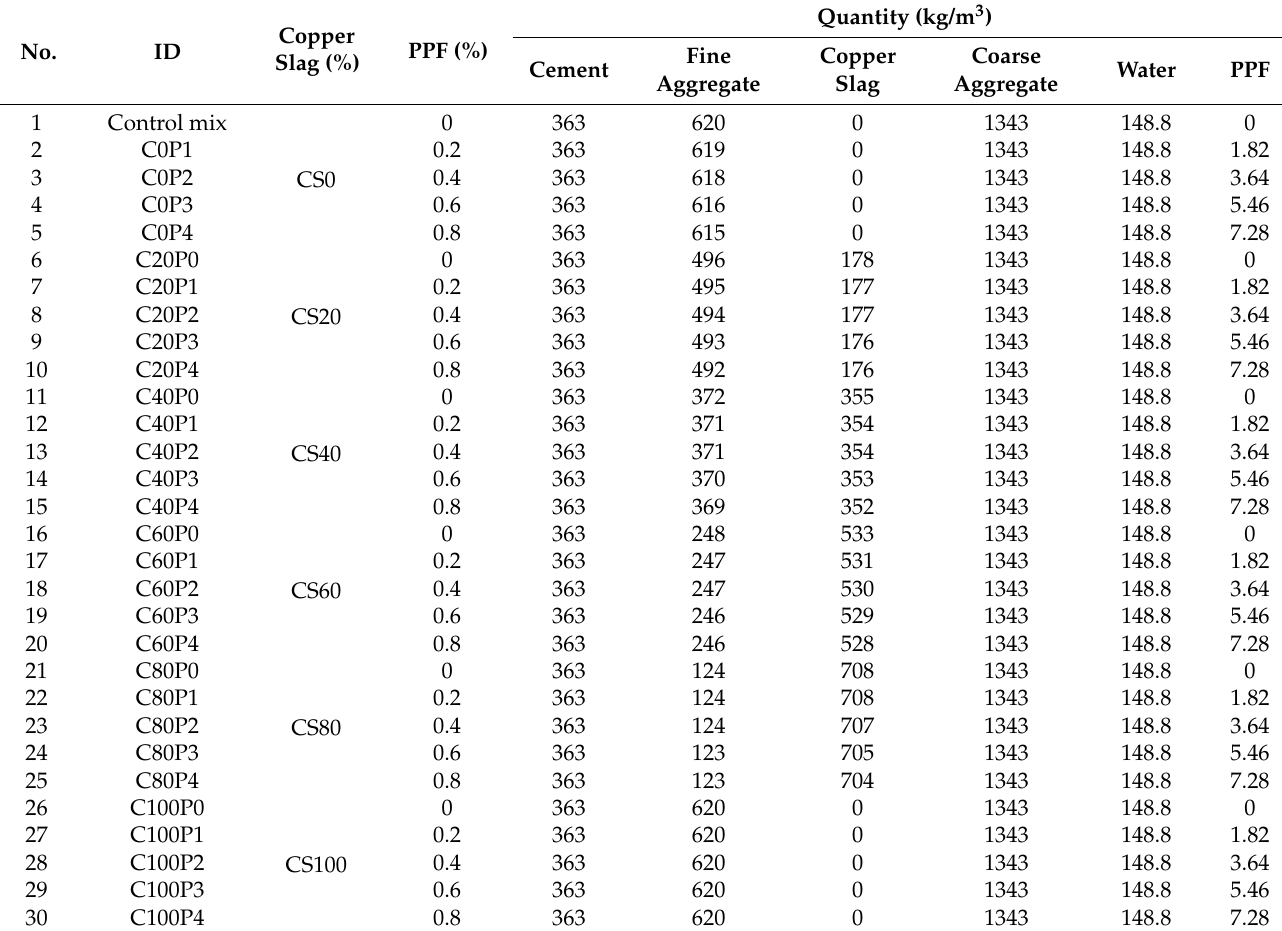
Table 3. Quantity of the material per cubic meter for all proportions.